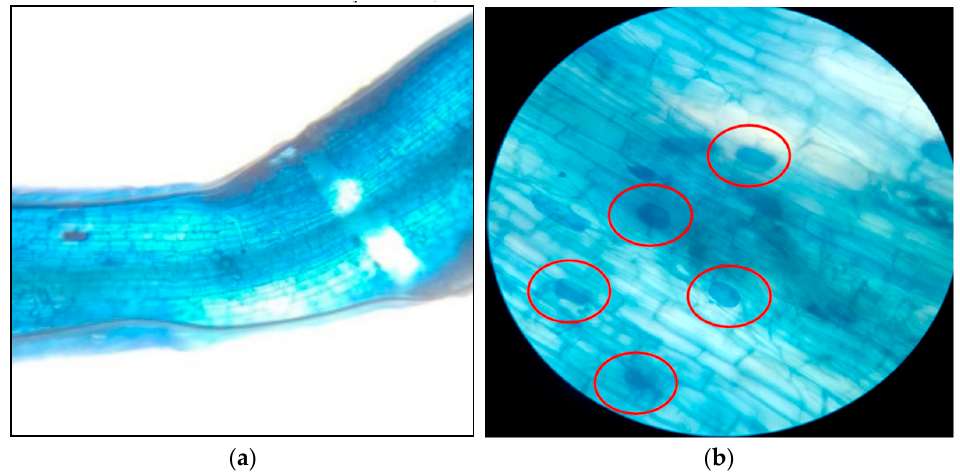
Figure 3. ( a ) Stained calafate fine root section, viewed microscopically at 10×; hydric replenishment rate of 50% ET 0 . ( b ) AMF vesicles in stained calafate fine roots (structures circled in red), viewed microscopically at 40×; hydric replenishment rate of 50% ET 0 . AMF: Arbuscular mycorrhizal